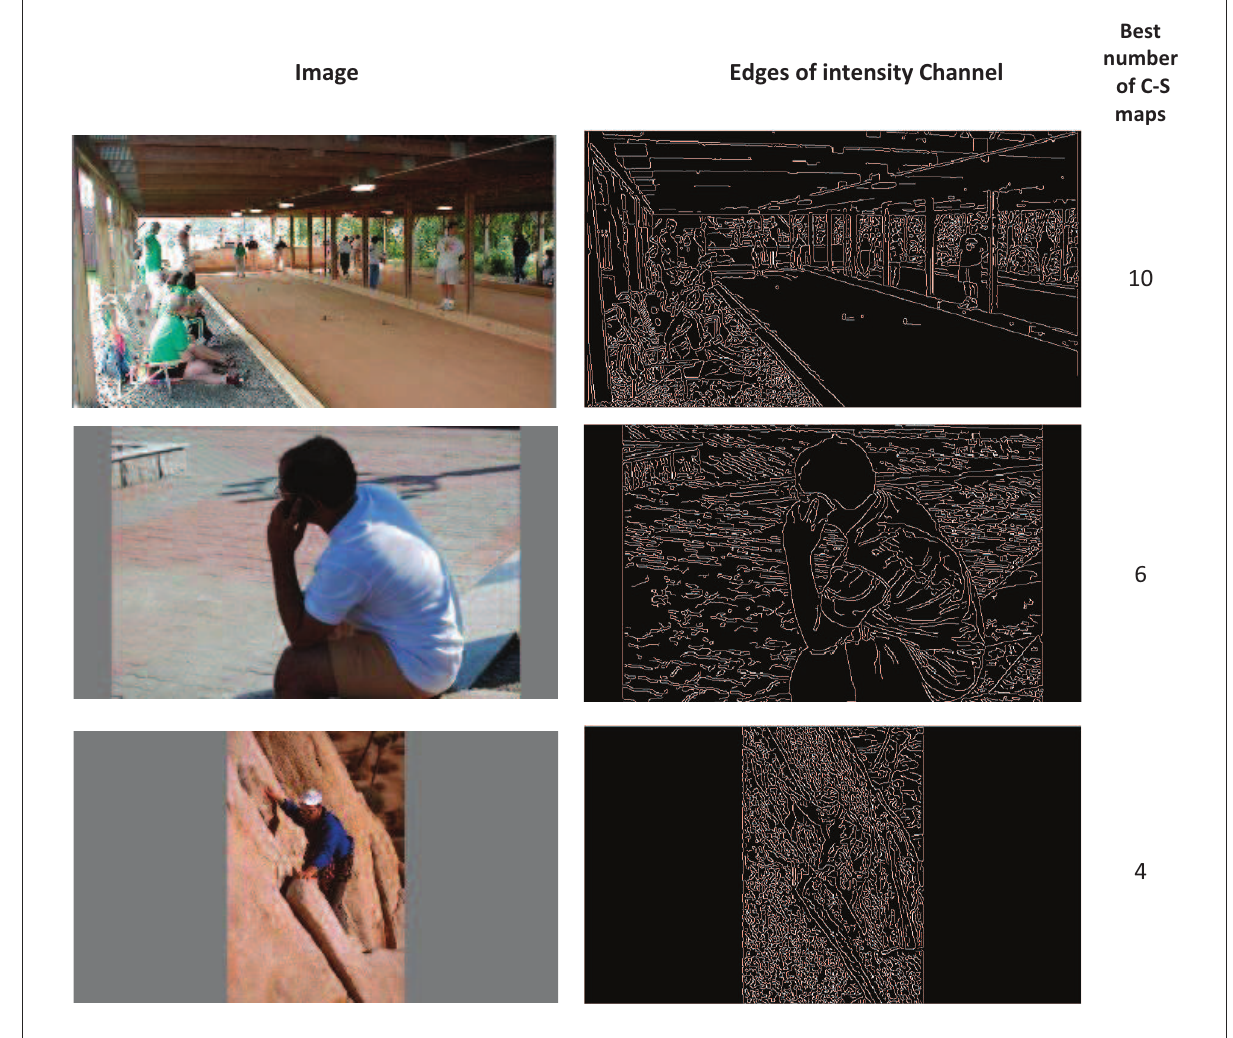
FIGURE6 The results for edge detection of sample images of Figure 5. The images are shown as examples for the best number of 4, 6, and 10 for C–S difference maps. The edge detection shows a rough estimation of the detailed and coarse content of the images. The edges are obtained for the intensity channel of the